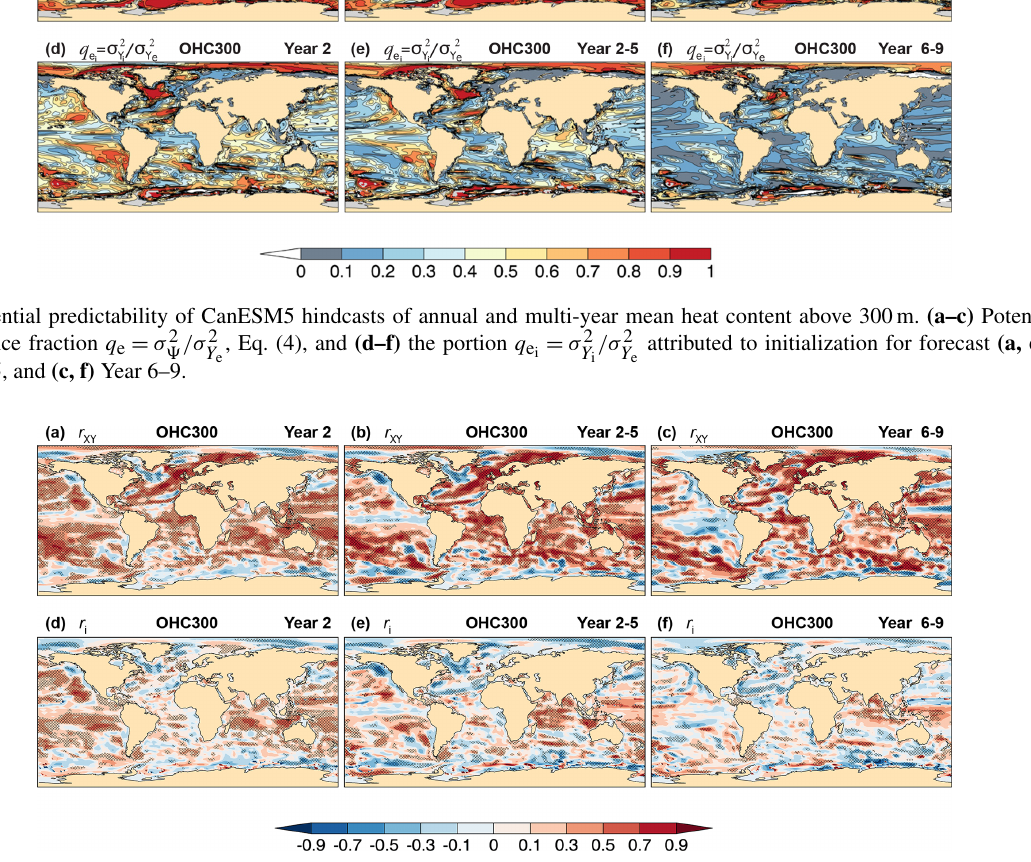
Figure 2. Skill of CanESM5 hindcasts of annual and multi-year mean heat content above 300m. (a–c) Correlation skill r XY , Eq. (6), and (d–f) contribution from initialization r i to correlation skill, Eq. (A17), for forecast (a, d) Year 2, (b, e) Year 2–5, and (c, f) Year 6–9. The verifying observations are derived from the EN4.2.1 data set (Appendix B). Cross-hatched regions indicate values significantly different from zero at the 90% confidence